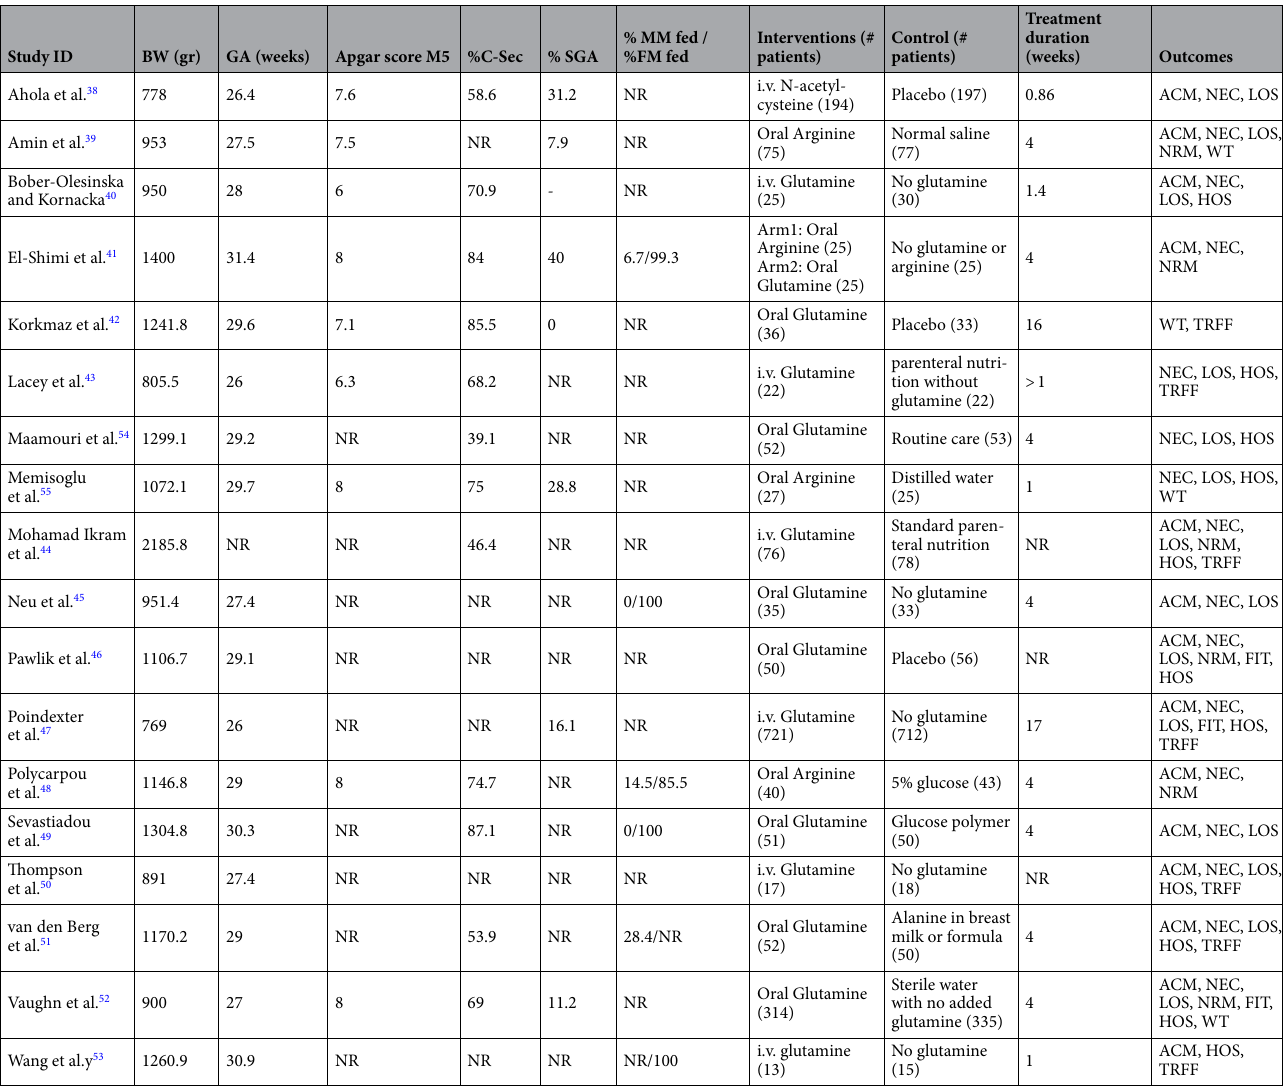
Table 1. Characteristics for included studies. BW-birth weight, GA-gestational age, Apgar M5- APGAR score at 5-min, %C-Sec-percent infants delivered by caesarean, % SGA- percent infants for small gestational age, % MM fed- percent infants exclusively fed with mother’s milk, %FM fed- percent infants exclusively fed with formula milk. NEC: Necrotizing enterocolitis; ACM: All-cause mortality; LOS: Culture-proven Late-onset sepsis, TRFF: Time to reach full enteral feeding, HOS: Duration of hospital Stay; WT: weight at term (weight at 37 weeks’ postnatal age); NRM; NEC-related